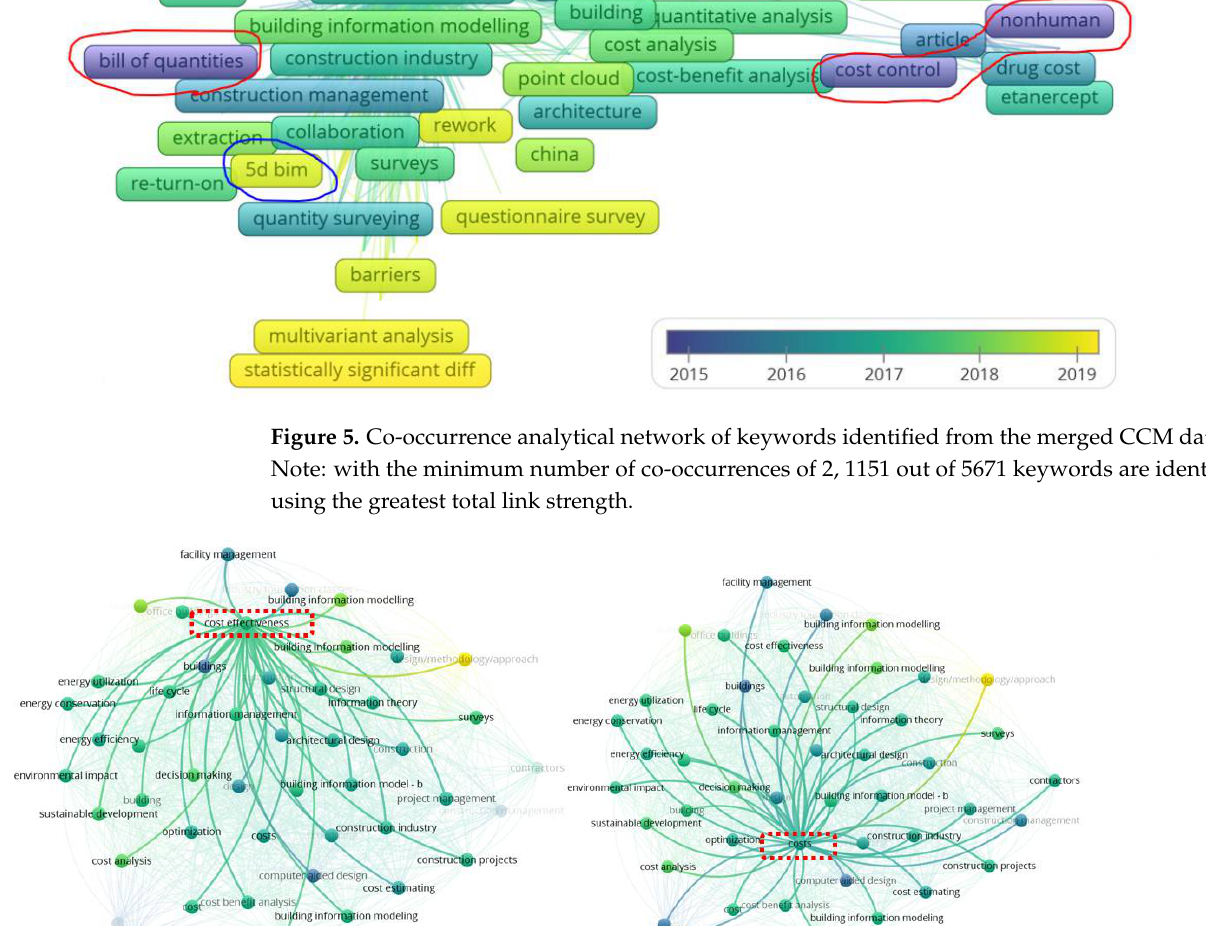
Figure 6. The cost and cost-effectiveness co-occurrence analytical maps of relevant keywords within CCM. Considering a minimum number of co-occurrences of 20, 47 keywords are identified. Note: the greatest total link strength ranging was used for selecting co-authors.